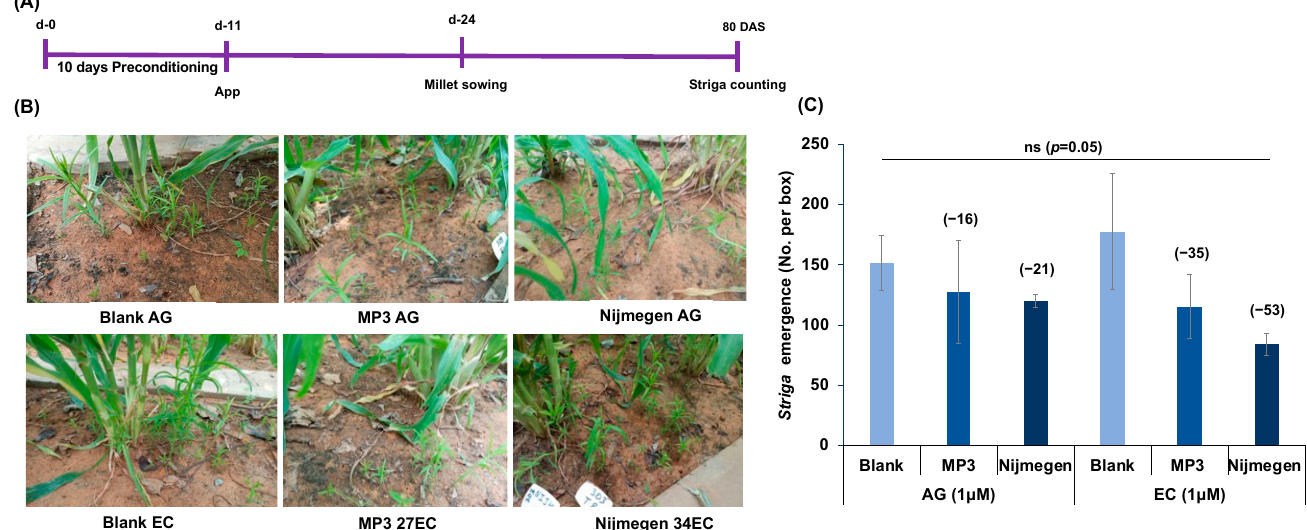
Figure 7. Effect of various formulations of SL analogs on Striga emergence under mini-field conditions at ICRISAT, Niger. ( A ) Scheme of the experiment conducted for Striga germination and emergence. ( B ) View of miniboxes and Striga infestation. Each box was filled with the soil, infested with Striga seeds collected from a pearl millet field in Niger. ( C ) Average number of Striga emergence in response to formulated MP3 and Nijmegen application. Striga emergence was counted after 80 days of pearl millet planting. Values of each bar showed average of Striga emergence per minibox. Data are means ± SE ( n = 3). Values in parenthesis are showing the percentage increase (+) or decrease ( − ) over blank treatment. ns: